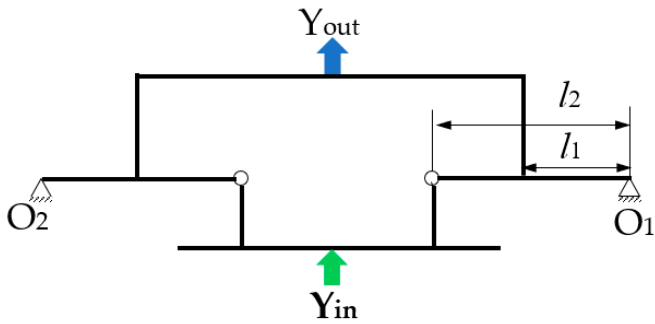
Figure 5. Principle diagram of micro-drive reduction mechanism.